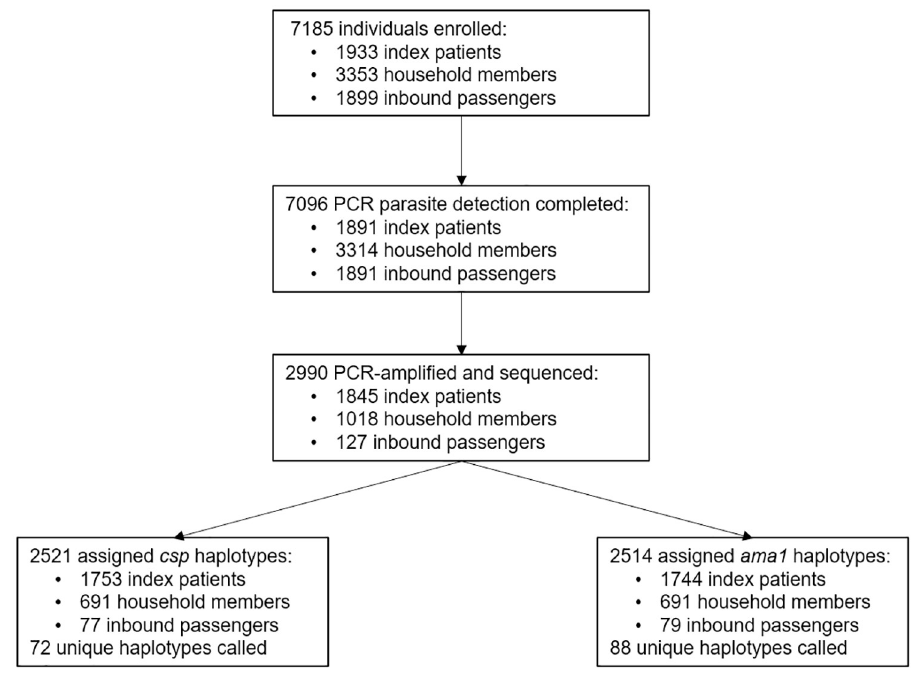
Fig 1. Study design, enrollment, sequencing, and